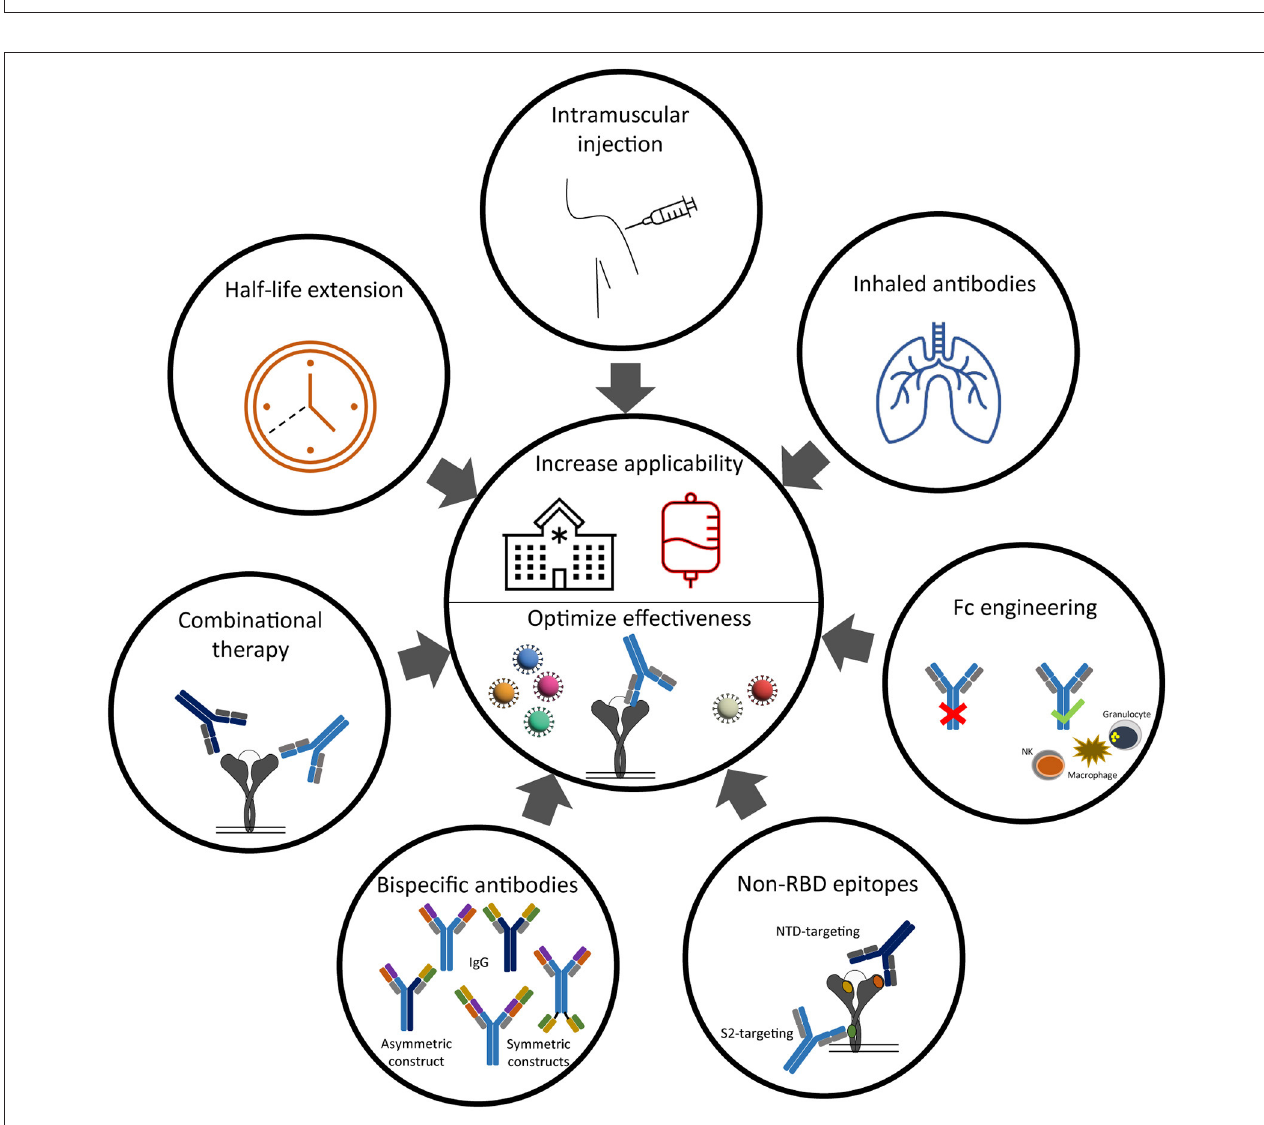
FIGURE 1 | sotrovimab (PDB: 6WPT), tixagevimab (PDB: 7L7E), cilgavimab (PDB: 7L7E) and regdanvimab (PDB: 7CM4). The right panels are zoomed in on the interaction between the Fabs and the RBD of the S protein. These figures were made with ChimeraX, version 1.3. (B) shows amino acid mutations in the Wuhan-Hu-1 reference sequence (GeneID: 43740578) that result in antigenic escape of the listed monoclonal antibodies. The arrows indicate RBD mutations harbored by the Beta and Gamma variants (orange), the Delta variant (red) or the Omicron variant (light blue). The N501Y mutation is shared by all variants and is indicated by a black arrow. Antigenic escape data is obtained from Bloom et al. (43).